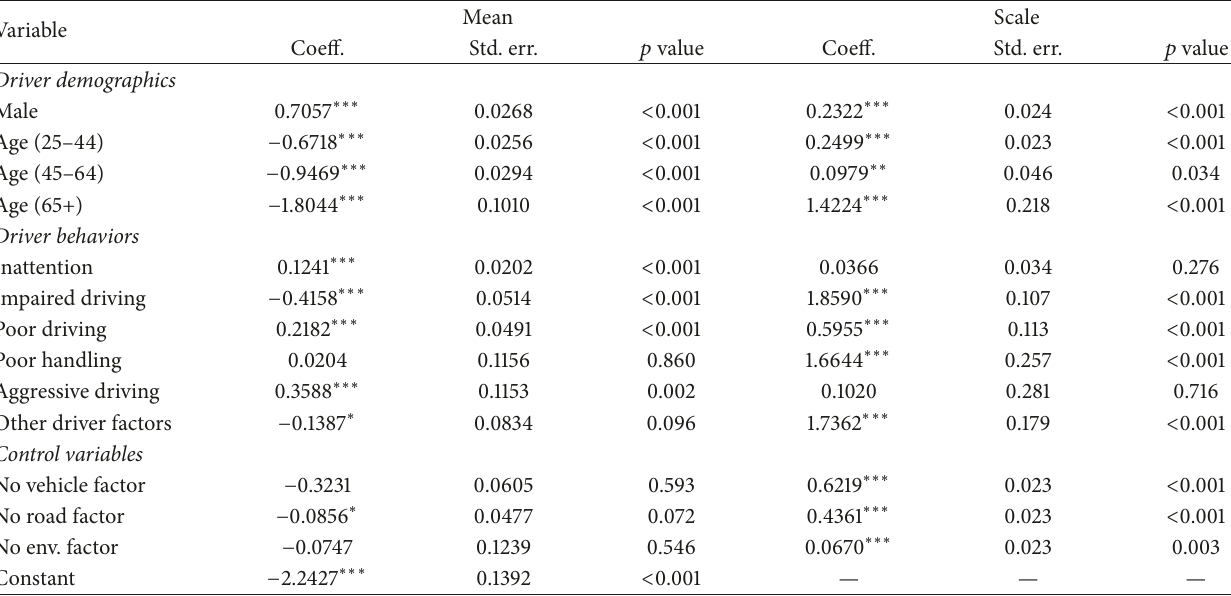
Table 4: Estimation results of random parameters binary logit